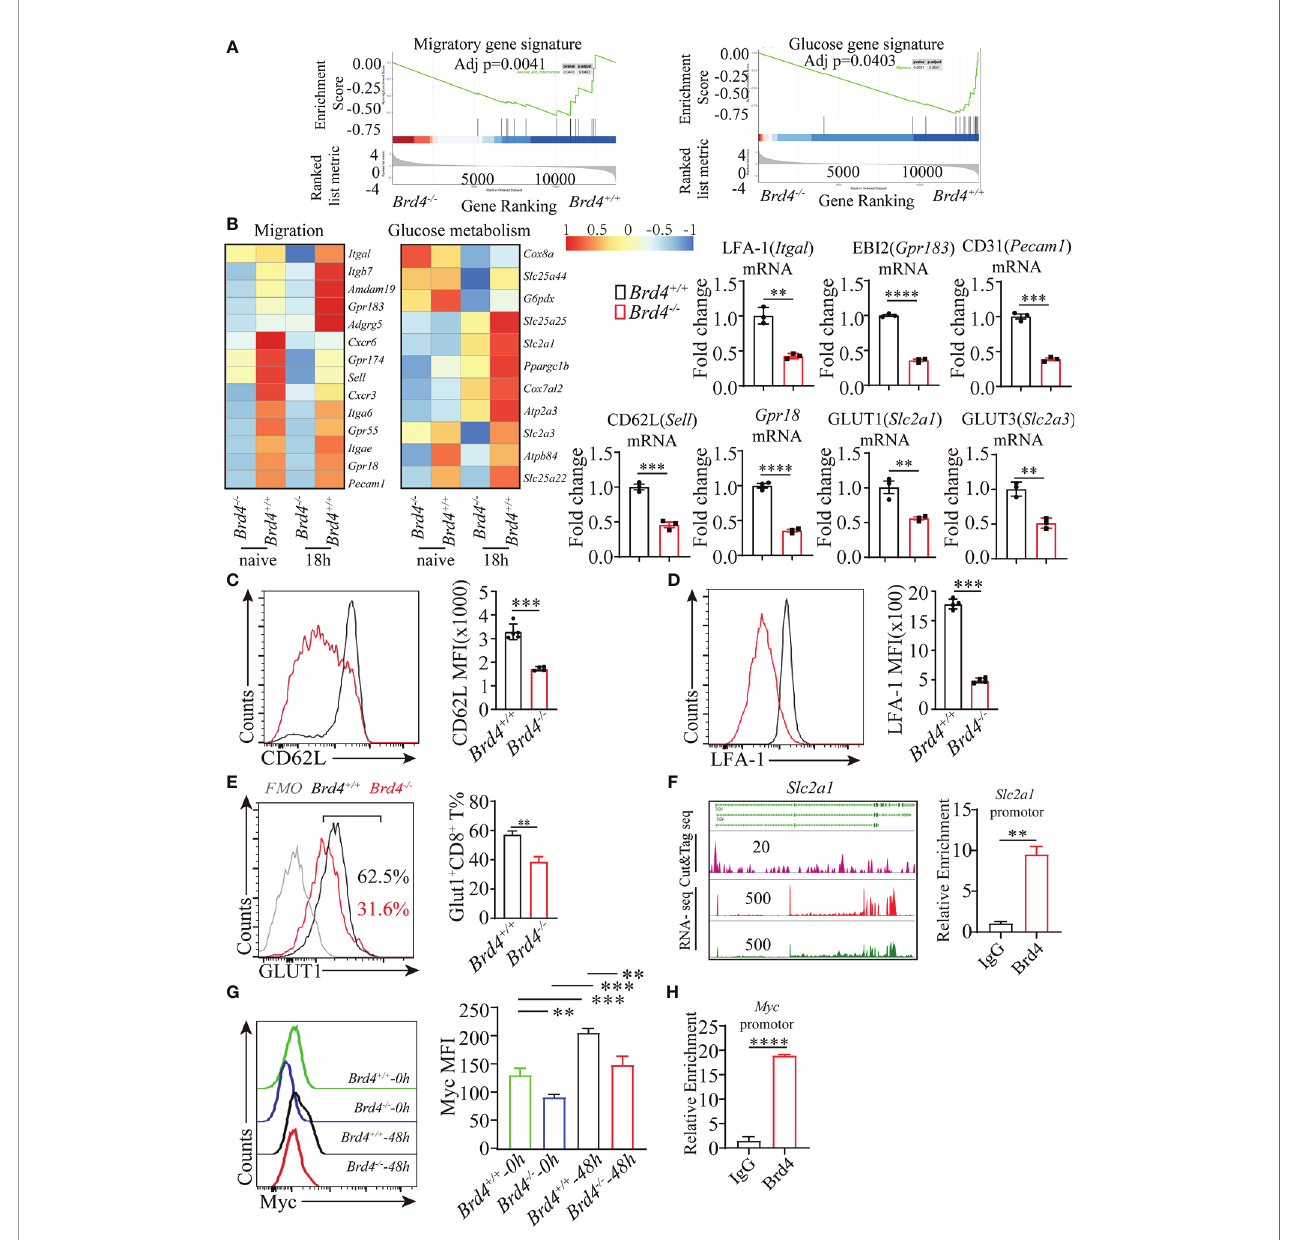
FIGURE 4 | Brd4 regulates migration- and glucose metabolism-related gene transcription. (A) GSEA enrichment analysis of genes involved in glucose metabolism and cell migration. (B) Heat map showing the downregulated genes in CD8 + T cells after Brd4 deletion and RT-qPCR con fi rmation of downregulated genes. (C) Flow cytometry showing the expression of CD62L in naïve CD8 + T cells. (D) Flow cytometry showing the expression of LFA-1 in naïve CD8 + T cells. (E) Flow cytometry analysis of GLUT1 expression in naïve CD8 + T cells. (F) CUT&Tag analysis showing the binding sites of BRD4 in Slc2a1 gene loci (left) and ChIP-qPCR con fi rmation of the enrichment of BRD4 in Slc2a1 loci in CD8 + T cells (right). (G) Intracellular staining for Myc detection in Brd4 +/+ and Brd4 -/- naïve and activated CD8 + T cells. (H) ChIP-qPCR con fi rmation of the enrichment of BRD4 in Myc locus in CD8 + T cells. The data was analyzed by two-tailed unpaired t -test between two independent groups. Results were indicated as mean ± sem (error bars). **p < 0.01; ***p < 0.001; ****p < 0.0001. Each experiment repeats more than 3